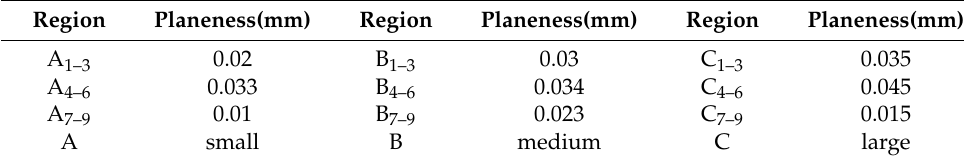
Figure 16. Flatness measurement of glass fingerprint touch plate. Table 5. Flatness of glass fingerprint touch